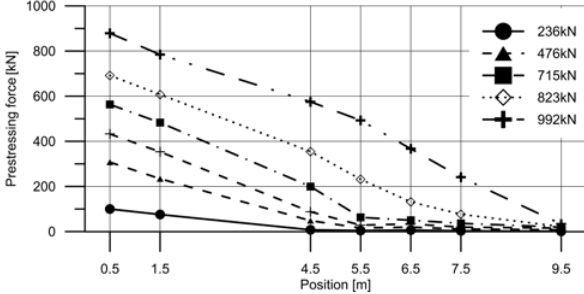
Figure 10. Measured distributions of pre-stressing force.